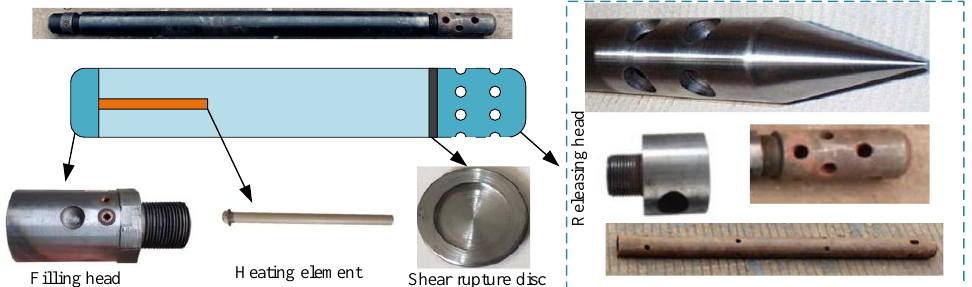
Figure 3. Carbon dioxide phase transition blasting